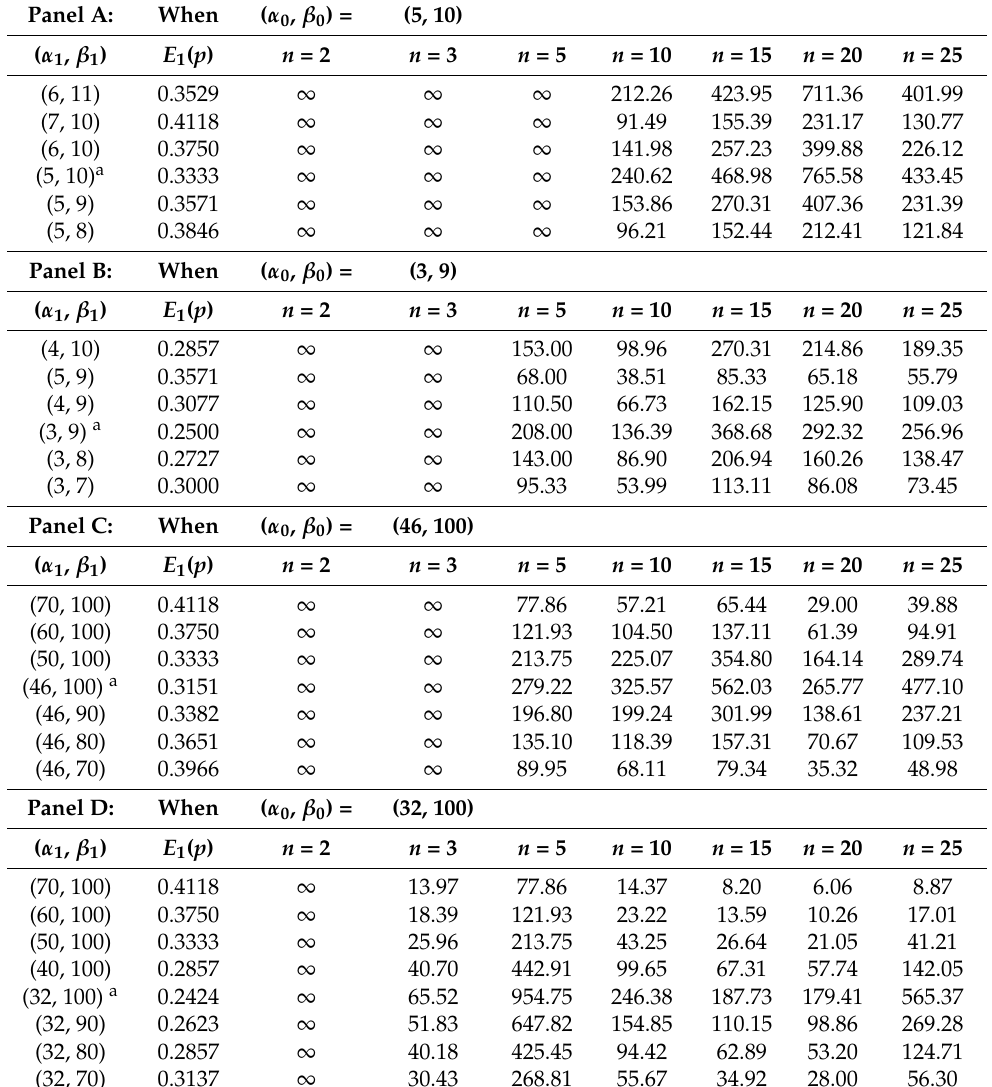
Table 2. The ARL 1 s of the proposed Shewhart-type Bayesian variance